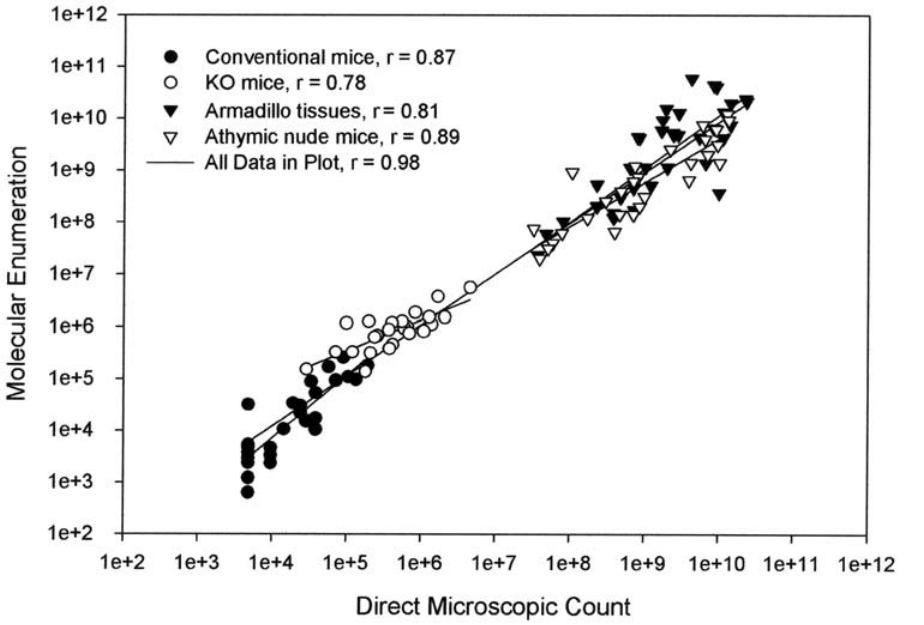
Figure 2. Comparison of direct microscopic counting of AFB per standard volume with enumeration of M.leprae by RLEP TaqMan PCR from tissues originating from a variety of host animals. Symbols identify individual samples from sets of conventional, TNFR1 knock-out (KO), and congentially athymic nude mice, as well as from nine-banded armadillos. Pearson’s coefficient (r 2 ) is calculated for each tissue set. Enumeration estimates for all tissues combined showed high correlation (r 2 =0.96) between the ‘‘gold standard’ direct microscopic counting and estimates based on RLEP TaqMan PCR.